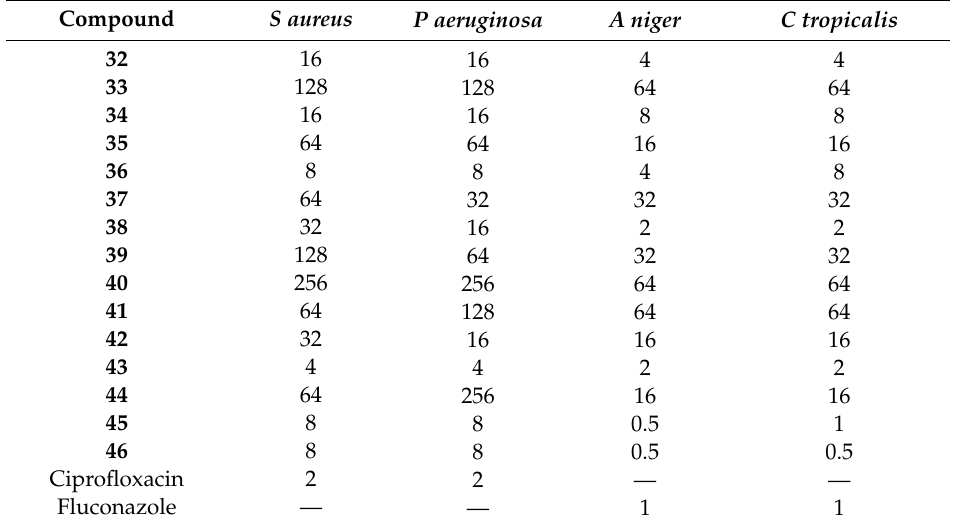
Table 2. Results of the antibacterial and antifungal activity of dihydropyrazoles (MIC µ g / mL; 32 – 46 ). Compound S